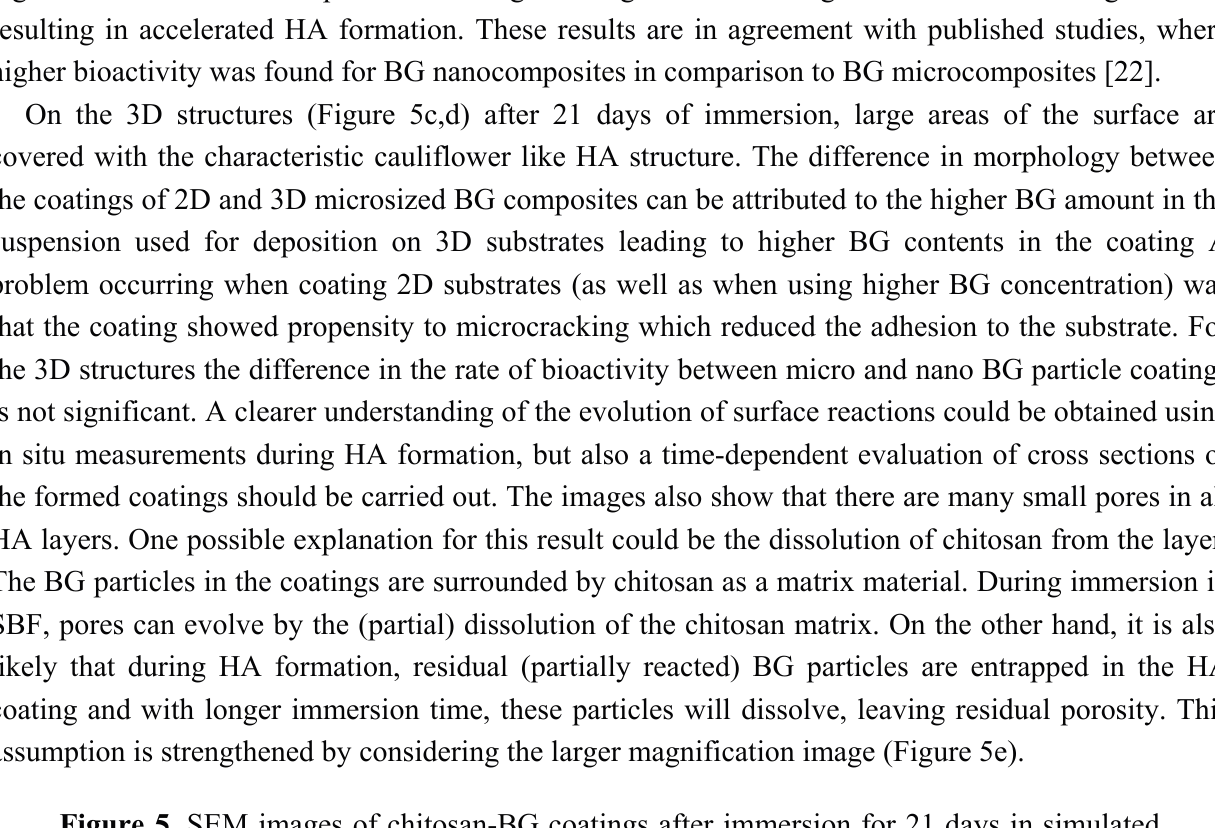
Figure 5. SEM images of chitosan-BG coatings after immersion for 21 days in simulated body fluid (SBF) for BG micro-particle composites on 2D ( a ) and 3D ( c ) substrates and for nanosized BG composites on 2D ( b ) and 3D ( d , e )